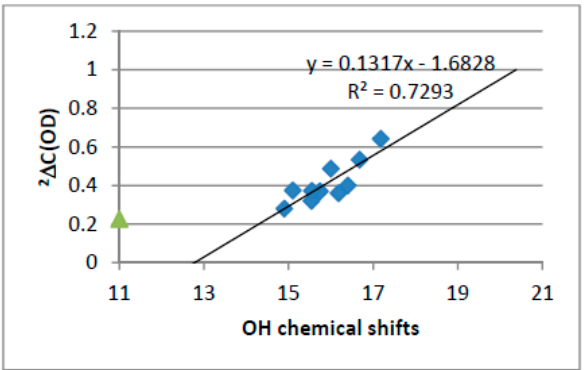
Figure 28. Plot of two-bond deuterium isotope effects vs. OH chemical shifts of 10-hy- droybenzo[h]quinolones. Taken from Ref. [71].